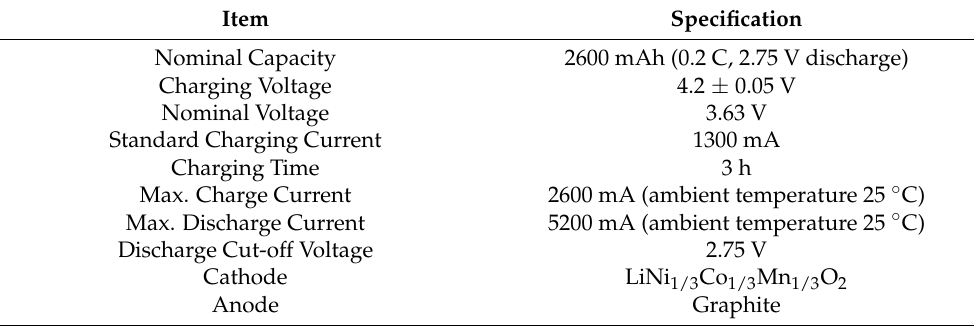
Figure 6. Current pulse. Nine SoC reference points were selected, evenly distributed in the range from 0 to 100%. Experiments have shown that nine points provide estimation accuracy with an er- ror below 5%. For each state of charge (%) (0, 12.5, 25, 37.5, 50, 62.5, 75, 87.5, 100), multiple voltage responses are measured for identical current pulses. The transfer function param- eters are calculated from each voltage response through an optimization process to obtain parameters for which the error in voltage estimation is minimal according to the ISE cri- terion. Figure 7 shows the measured voltage response to the current pulse and the Simulink model voltage with estimated parameters for the reference point SoC = 50%. The difference between the signals is caused by noise. When this learning process is completed for all reference points, i.e., SoC s, the vector of transfer function coefficients x R is stored in the